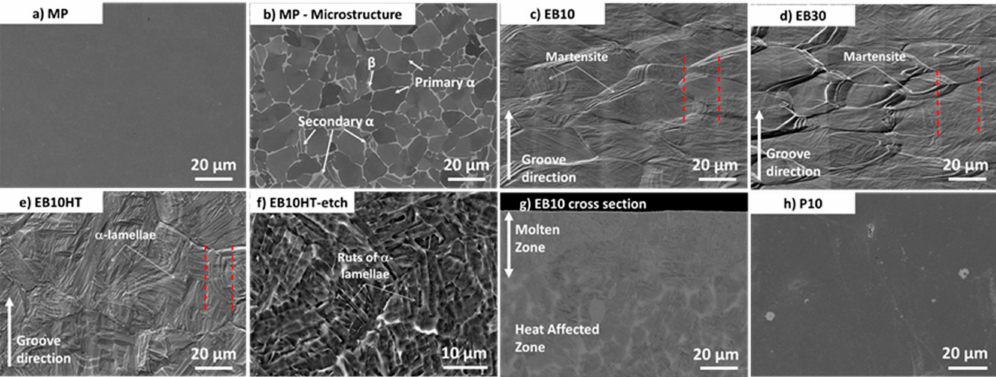
Figure 1. FESEM images of the samples: ( a ) MP sample (Secondary Electron (SE) image); ( b ) MP sample (BSE image); ( c ) EB 10 sample (SE image); ( d ) EB 30 sample (SE image); ( e ) EB10HT sample (SE image); ( f ) EB10HT-etch sample (SE image); ( g ) cross section of the EB10 sample (SE image); ( h ) P10 sample (SE